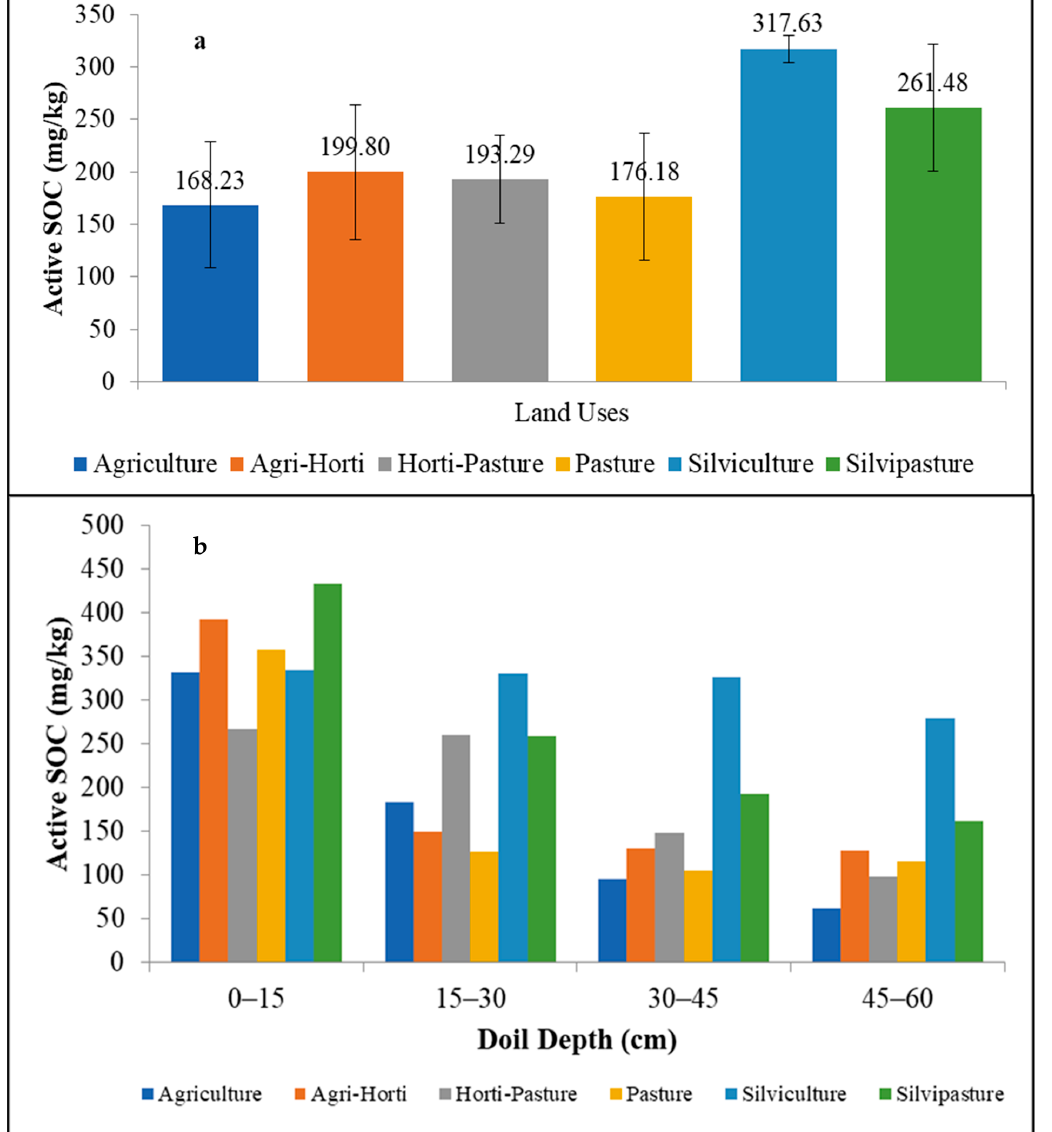
Figure 3. Variation in active soil organic carbon (mg kg − 1 ) ( a ) in whole soil profile (0–60 cm soil depth) and ( b ) in different soil layers under semi-arid climatic condition. Error bar ( a ) indicates the standard error values of active SOC under different land uses. T 1 —Agriculture, Glycin max .; T 2 —Agri-Horti, Manilkara achras and Glycin max ; T 3 —Horti-Pasture, Emblica officinalis and Cenchrus ciliaris , T 4 —Pasture, Cenchrus ciliaris ; T 5 —Silviculture, Accacia nilotica ; T 6 —Silvipasture, Accacia nilotica and Cenchrus ciliaris